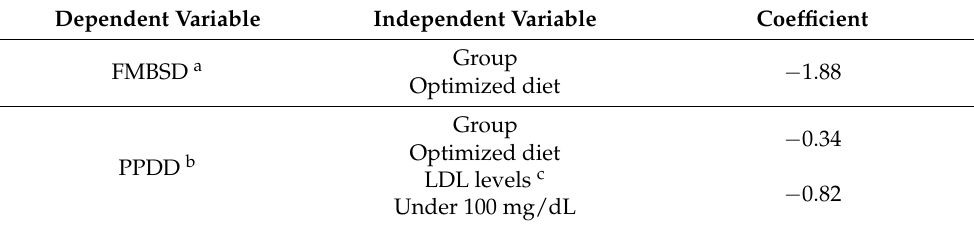
Table 4. The results of the regression